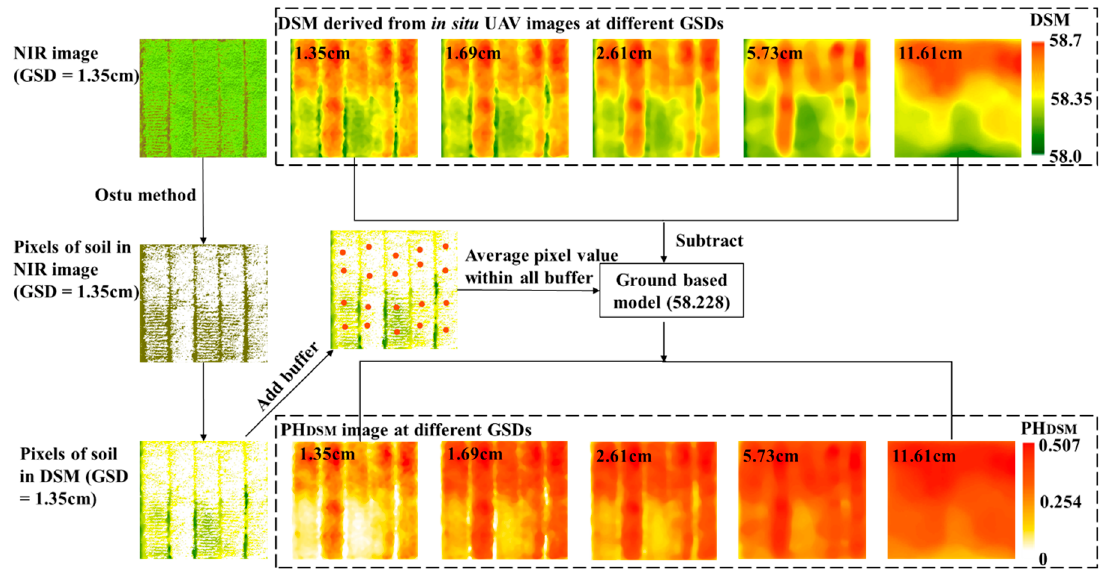
Figure 4. PH DSM at different ground sampling distances (GSDs). The red solid circles represented the buffers in Zonal Statistics as Table in ArcGIS for pixel value extraction.